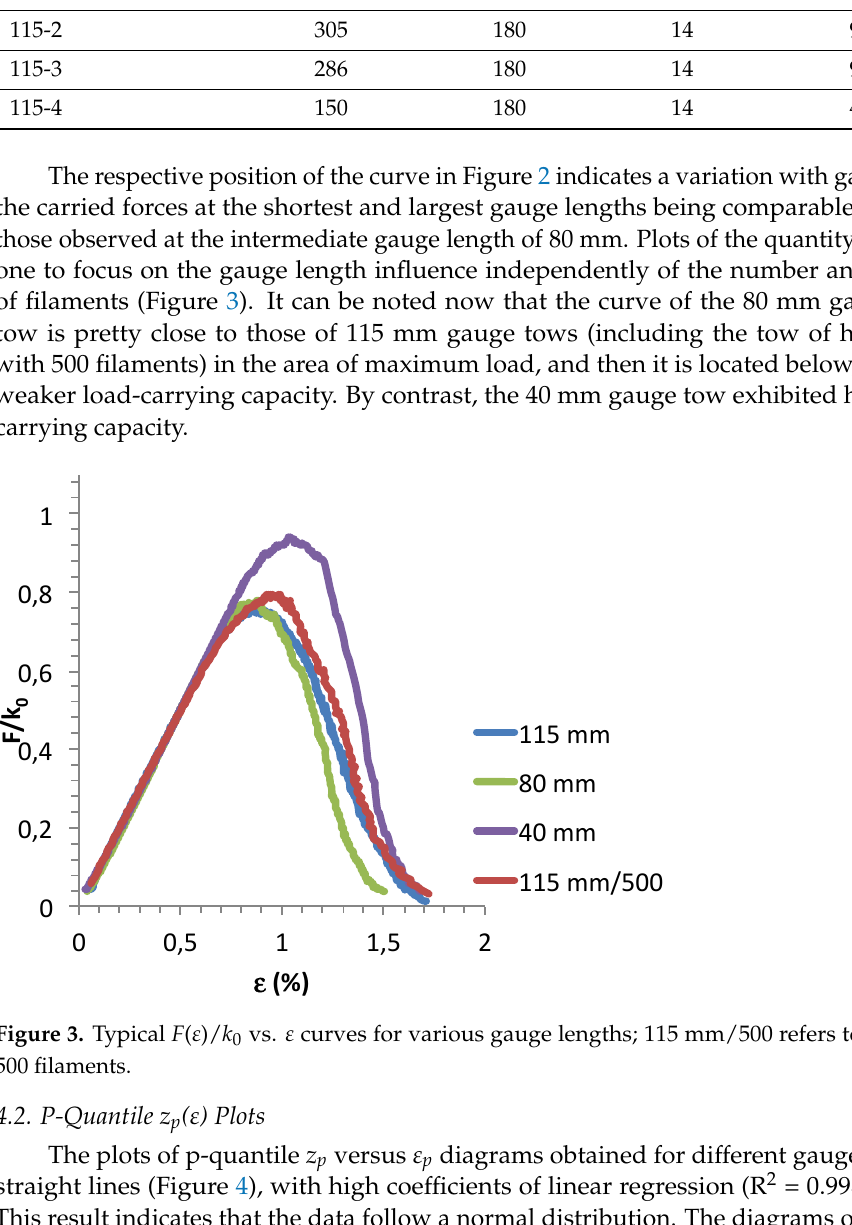
Table 2. Values of mean ( μ ) and standard deviation ( s ) derived from the slope (1/ s ) and the inter- cept ( μ / s ) of the z p ( ε p ) plots. R 2 (z p ) is the coefficient of determination that measures the global fit of Equation (6). Values of Weibull modulus ( m ) and scale factor ( ε l ) derived from mean ( μ ) and standard deviation ( s ). R 2 (Pn-PW) is the coefficient of correlation that measures the global fit of normal and Weibull distribution functions.